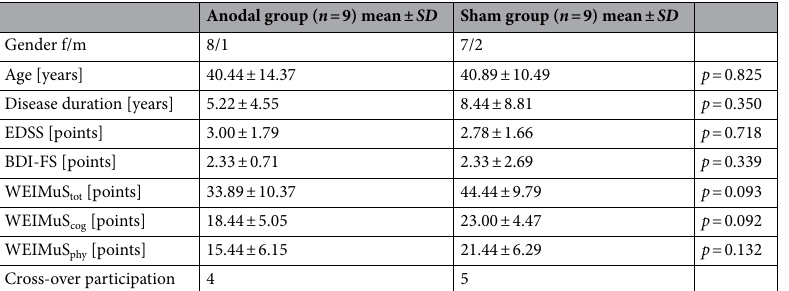
Table 1. Baseline group characteristics. BDI-FS Becks Depression Inventory Fast Screen, EDSS Expanded Disability Status Scale, WEIMuS Wuerzburg Fatigue Inventory for Multiple